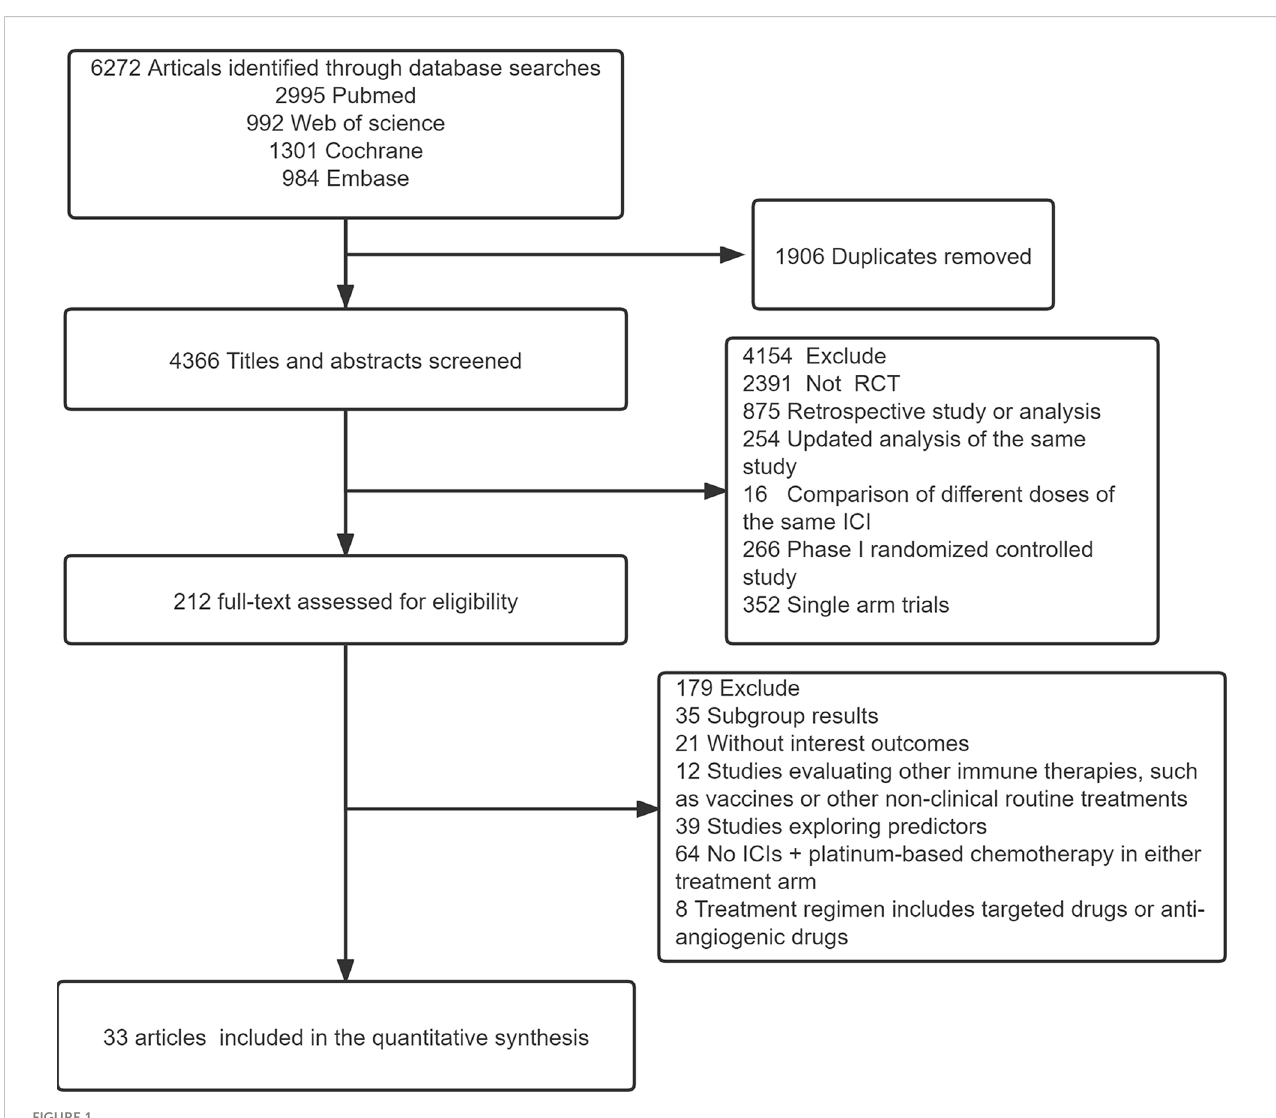
FIGURE 1 Flow diagram for the study selection process. ICI, immune checkpoint inhibitor; RCT, Randomized controlled